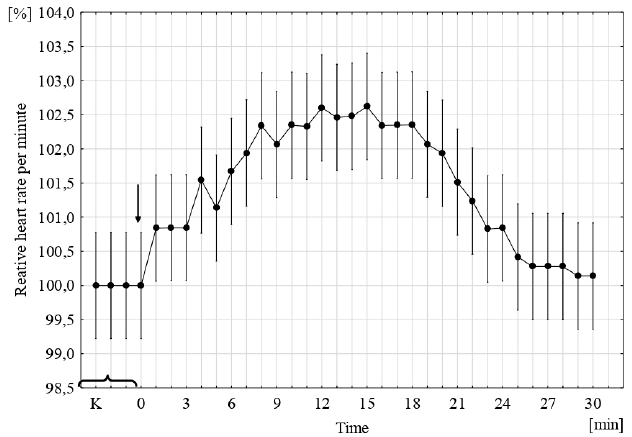
Figure 3. The relative number of cardiac contractions in sea trout embryos in the SMF (4 mT, p < 0.001, vertical bars denote 95% CI); the number of contractions in the control was assumed to be 100%. K—control, 0—the point at which the MF was switched on [43].